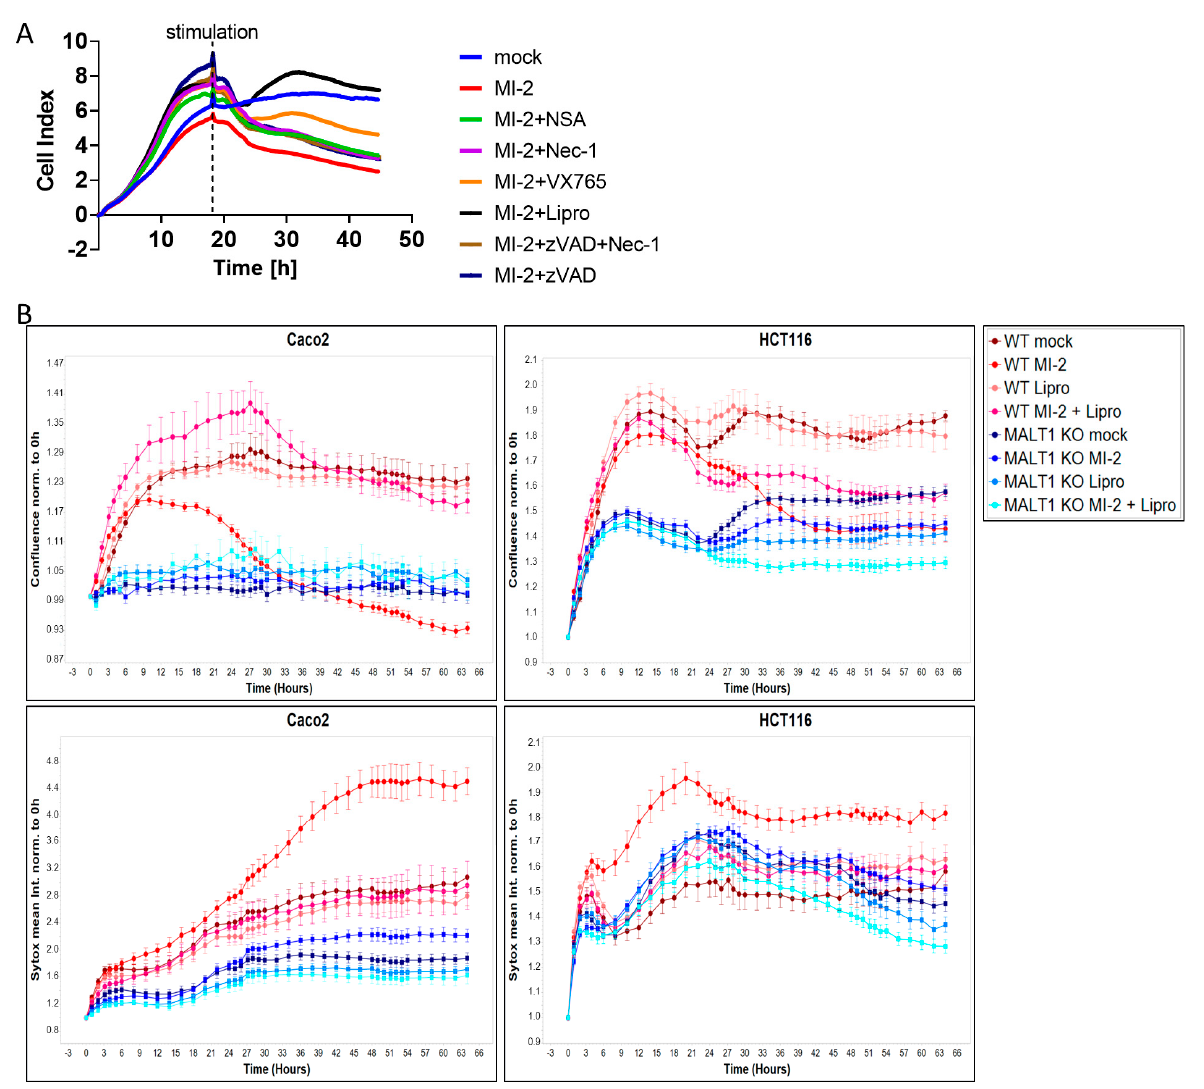
Figure 4. MALT1 protease negatively regulates ferroptosis in vitro. ( A ) Cell death screen of Caco2 cells stimulated with 13.5 µM MI-2, 0.5 µM necrosulfonamide (NSA), 10 µM necrostatin-1 (Nec-1), 20 µM VX-765, 20 µM z-VAD-FMK (zVAD) and 0.2 µM liproxstatin-1 (Lipro). ( B ) Live cell analysis of Caco2 and HCT116 cells stimulated with 13.5 µM MI-2 and 0.2 µM liproxstatin-1 (Lipro). Cell confluence (upper panel) and Sytox green intensity (lower panel) indicate cell growth and cell death over time (hours).